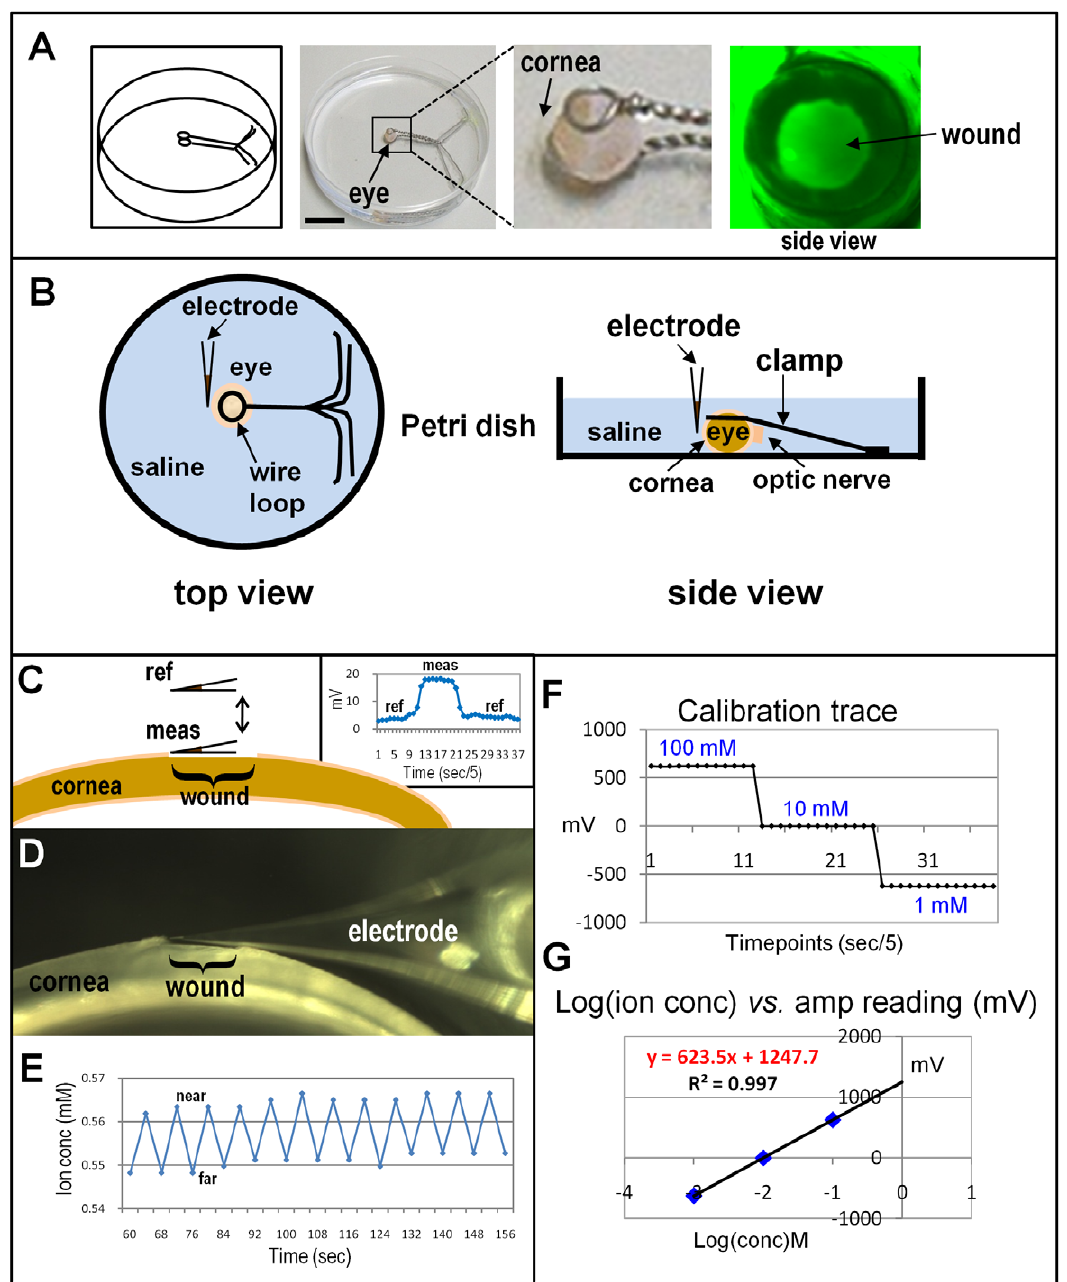
Figure 2. Measuring flux of specific ions at corneal wounds. A . Mounting eyes for wounding and probe measurements. A custom-made dish with wire loops holds the eye, leaving the cornea free for measurements and wounding (scale bar 2 cm). Right panel shown wound on cornea stained with fluorescein. B . For measurements, the cornea faces the electrode in the center of the dish. The eye can be rotated and/or the electrode moved to measure at different positions. C . Schematic showing wounded rat cornea with ion selective microelectrode in reference position (‘ref’) and measuring position (‘meas’) at the wound edge. Insert on right shows raw data recording trace (see Methods for details). D, E. Self-referencing mode. D . The electrode moves at low frequency (0.3 Hz) between two points (‘near’ and ‘far’) 30 m m apart at the wound edge. E . Recording trace which has been converted into ion concentration using the calibration trace (see below). F, G. Calibration. F . Calibration of the probe in standard solutions. G . A linear trendline obtained by plotting the amplifier output in mV vs. the logarithm of the ion concentration yields a formula (shown in red) used to calculate ion concentration and, in turn, the actual ion flux.